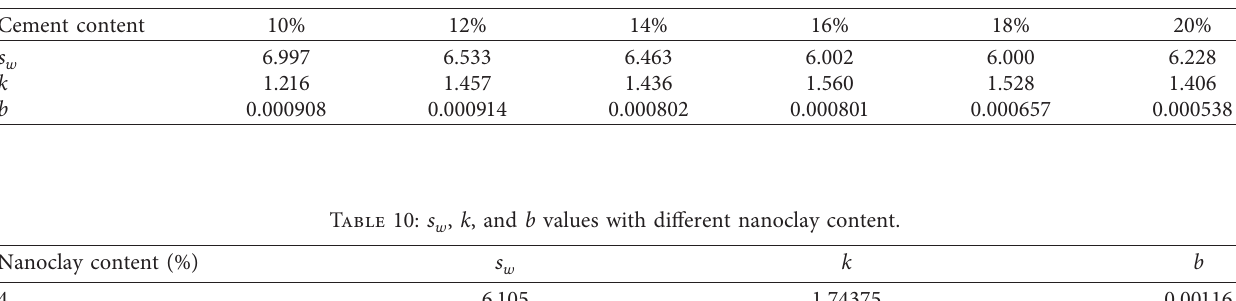
Figure 18: Fitting results with different consolidation pressure. Table 9: s w , k , and b values with different cement content.